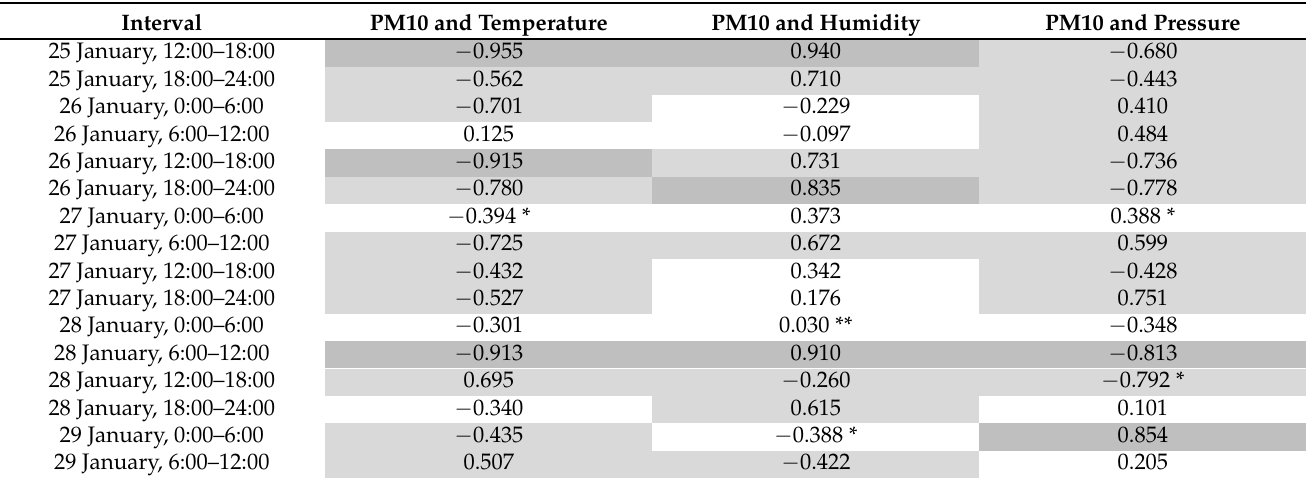
Table 7. Correlation between PM10 and temperature, humidity, pressure: 6-h intervals.